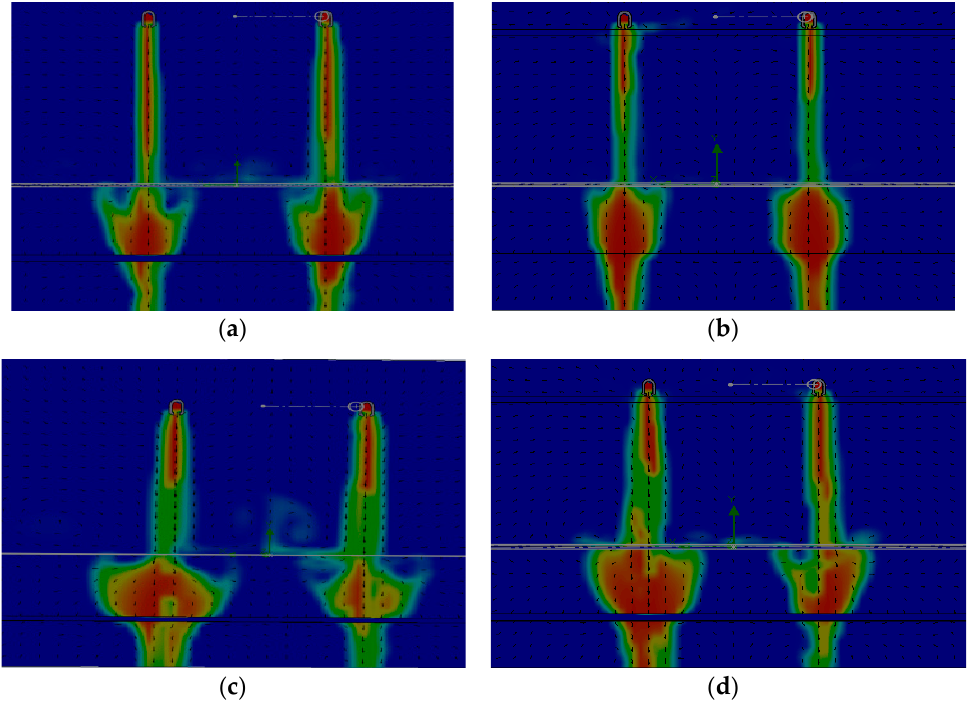
Figure 14. The distribution of mass concentration of water for: Q = 0.00025 m 3 /s: ( a ) without metal pad mesh and ( b ) with metal pad mesh; Q = 0.000666 m 3 /s: ( c ) without metal pad mesh and ( d ) with metal pad mesh.